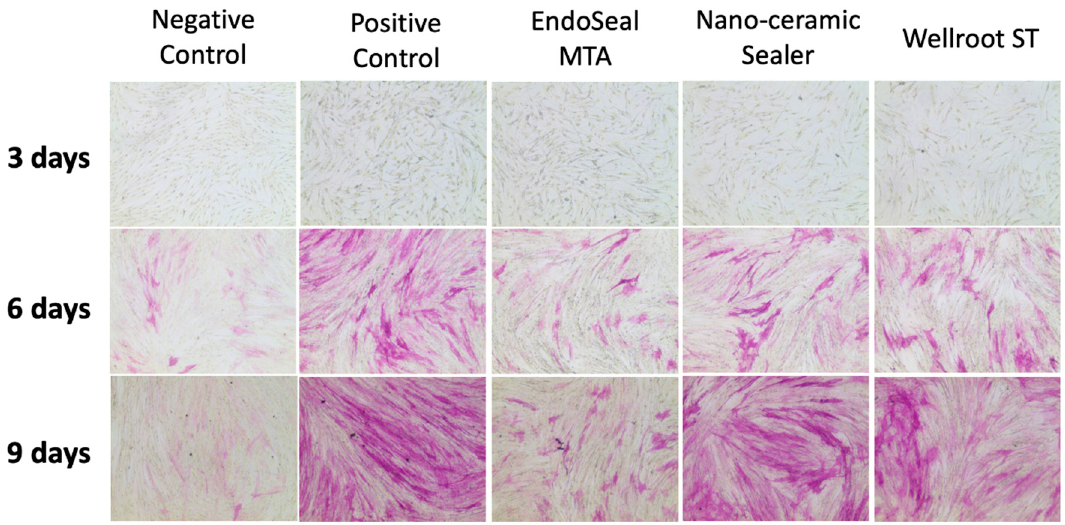
Figure 8. The effects of sealers on osteoblastic differentiation in a representative cell of hPDLSCs for 9 days using ALP staining. Wellroot ST and Nano-ceramic Sealer showed staining strength similar to that of positive control on 9 days.